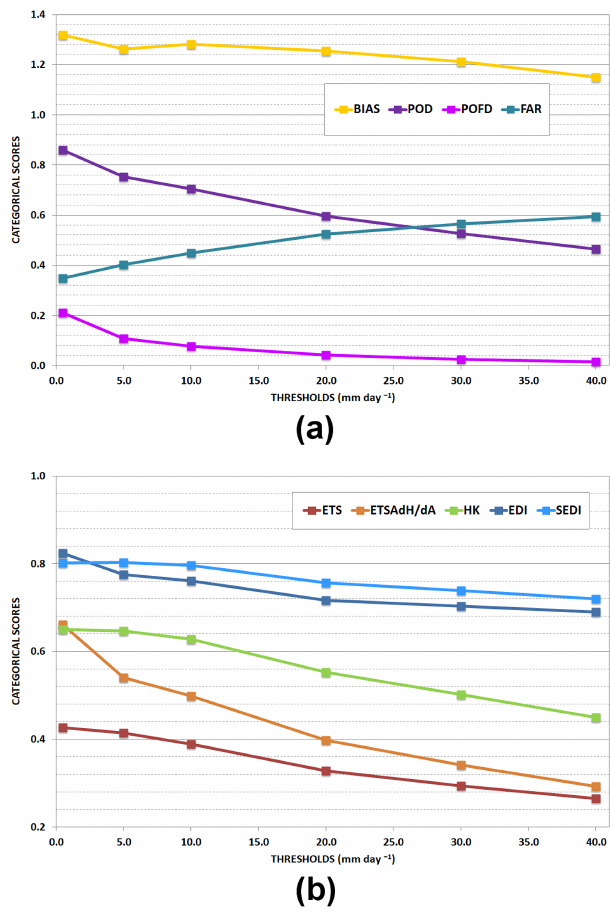
Figure 7. Categorical scores calculated over the period September– December 2012 for the 24h MOLOCH forecasts. (a) BIAS, POD, POFD, and FAR; (b) ETS, ETSA d h/ d A , HK, EDI, and SEDI.